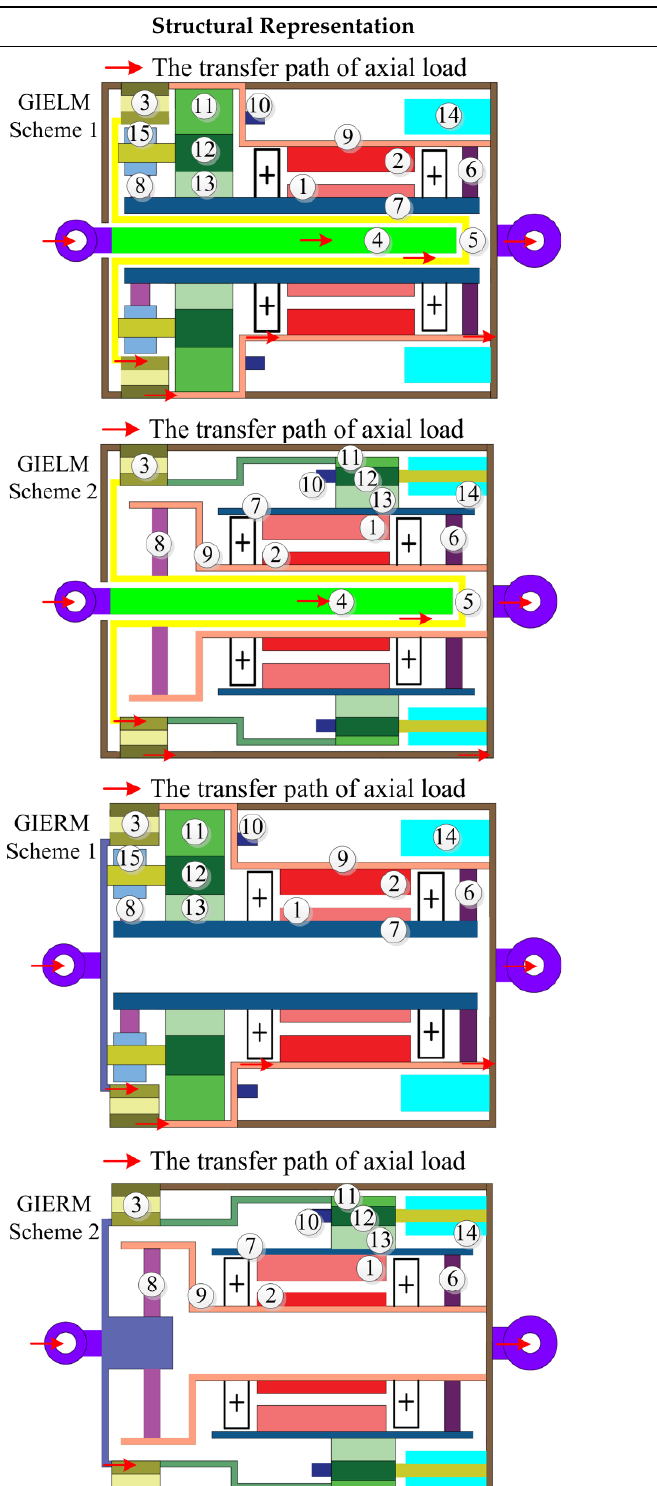
Table 1. Transmission scheme of GIELM and GIERM.